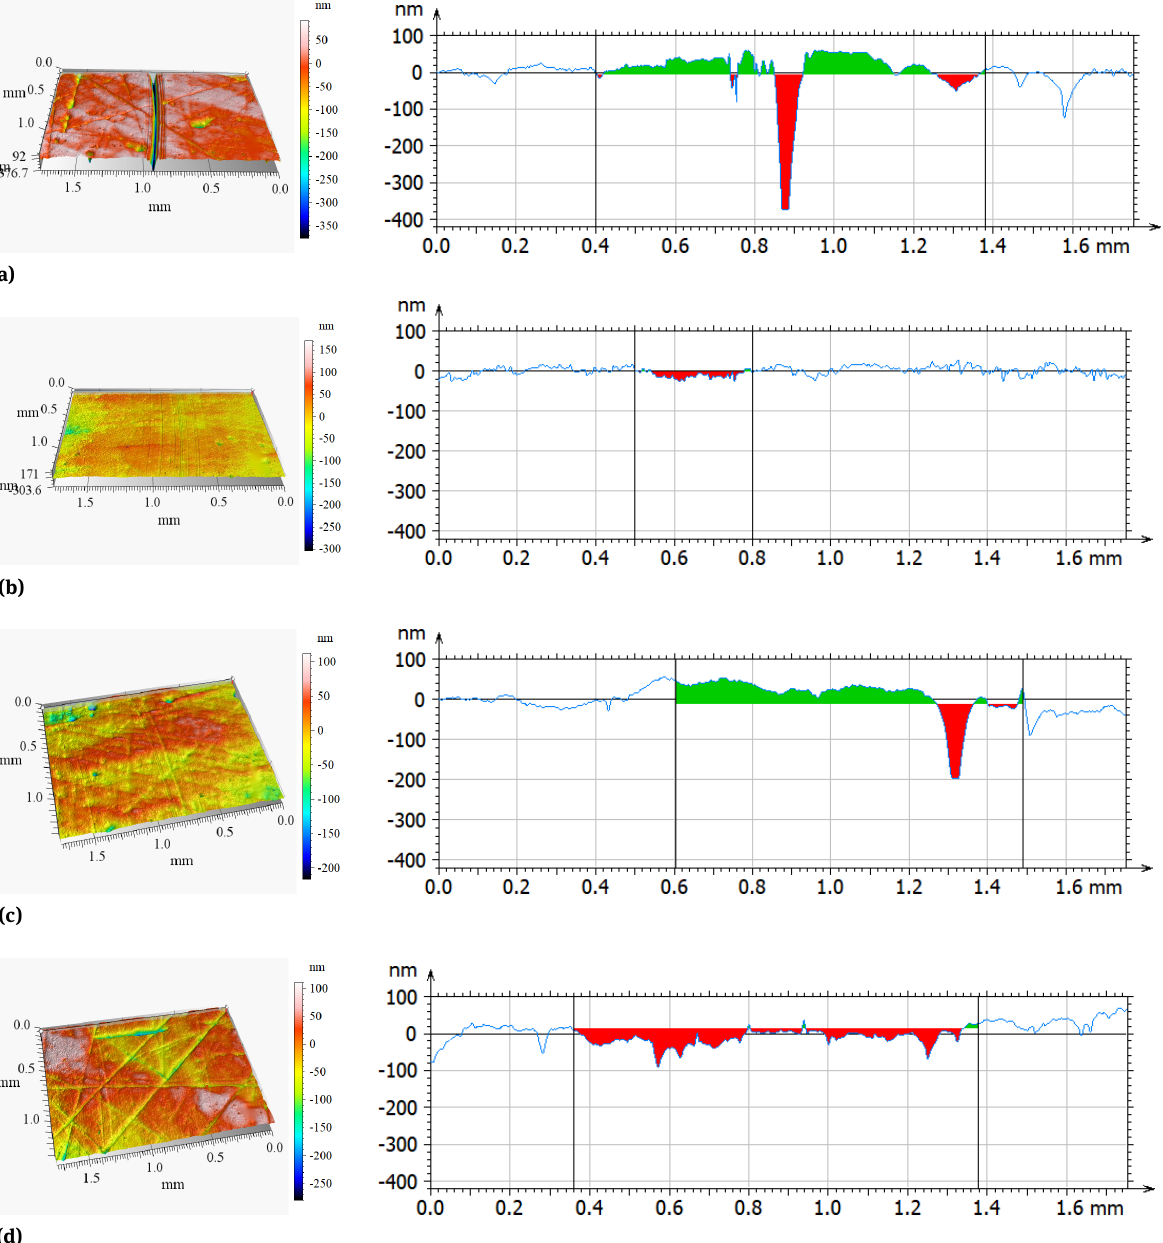
Figure 6: Isometric image and primary profile disks after tribological tests in the following conditions: a) TDS, b) IL1 lubrication, c) IL2 lubrication, d) BCCS lubrication.